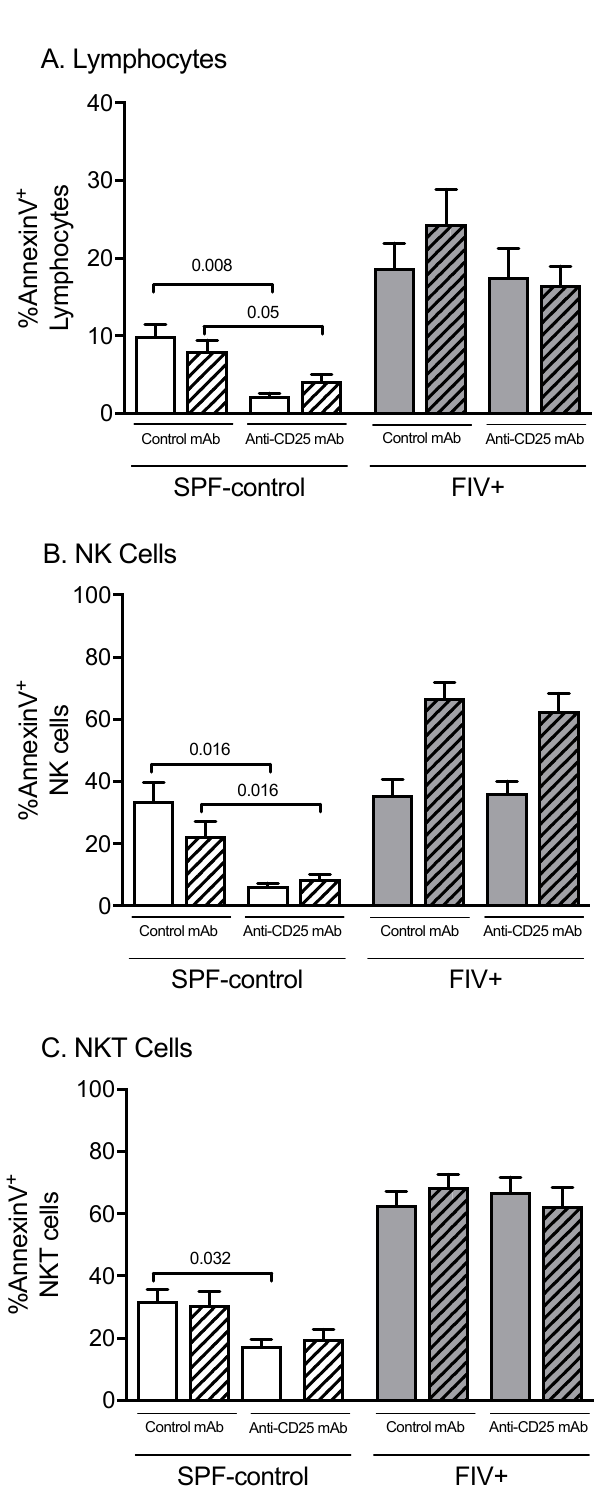
Figure 4. The e ff ects of Treg depletion on total lymphocyte, NK cell, and NKT cell apoptosis. Apoptosis was assessed in cats treated with isotype control mAb or anti-CD25 mAb by Annexin V staining, followed by flow cytometric analysis of lymphocytes from the control lymph node (open bars) versus Lm-draining lymph node (hatched bars). ( A ) Percentage of lymphocytes expressing Annexin V; ( B ) percentage of NK cells expressing Annexin V; ( C ) percent NKT cells expressing Annexin V. Statistical analysis was performed using one-way ANOVA with Tukey’s post-test; n = 6 for each treatment